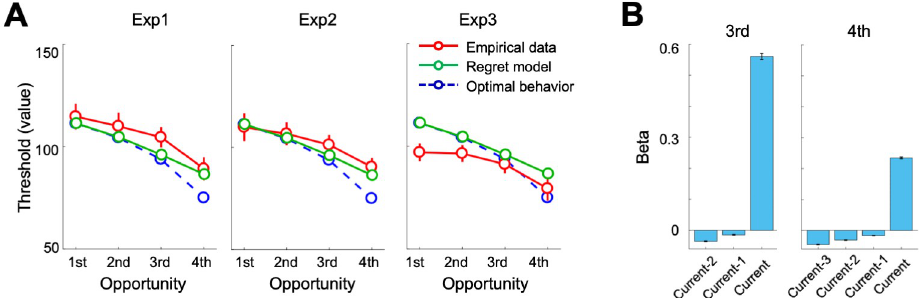
Fig 6. Subjective optimality model versus an alternative Regret model. As depicted in Fig I in S1 File, there are potential effects of past stimuli values on the subsequent choice. (A) To more directly examine potential effects of “regret”, individuals accept less likely the stimuli values that are above the optimal threshold but below a value which they have previously rejected, decision thresholds simulated with a regret model are compared against the optimal decision model and empirical data. Error bars indicate s.e.m. (B) Effects of past stimuli values on the current decision were examined by applying the logistic regression analyses using the simulated data from the regret model. The regret model predicts meaningful deviation from the optimal model in the 3 rd and 4 th opportunities, and the deviation can be attributed to the negative weight on the preceding opportunities. However, the regret model, inconsistent with the observed pattern from the empirical data ( Fig I in S1 File), predicts that the value in the earlier opportunities will affect the current decision more than the value in the recent past. Error bars indicate s.e.m.